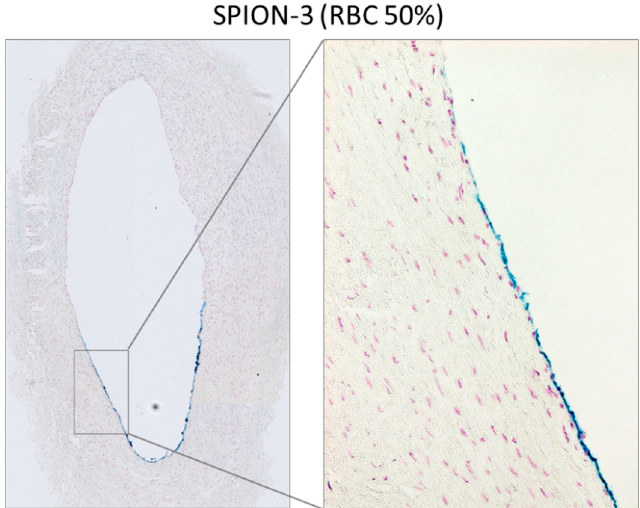
Figure 7. Detection of SPION-3 accumulation at the arterial wall using Prussian blue stain. Magnetically targeted segment 0 is shown as overview image and in 20x magnification for SPION-3 in RBC suspension at 50% Ht.